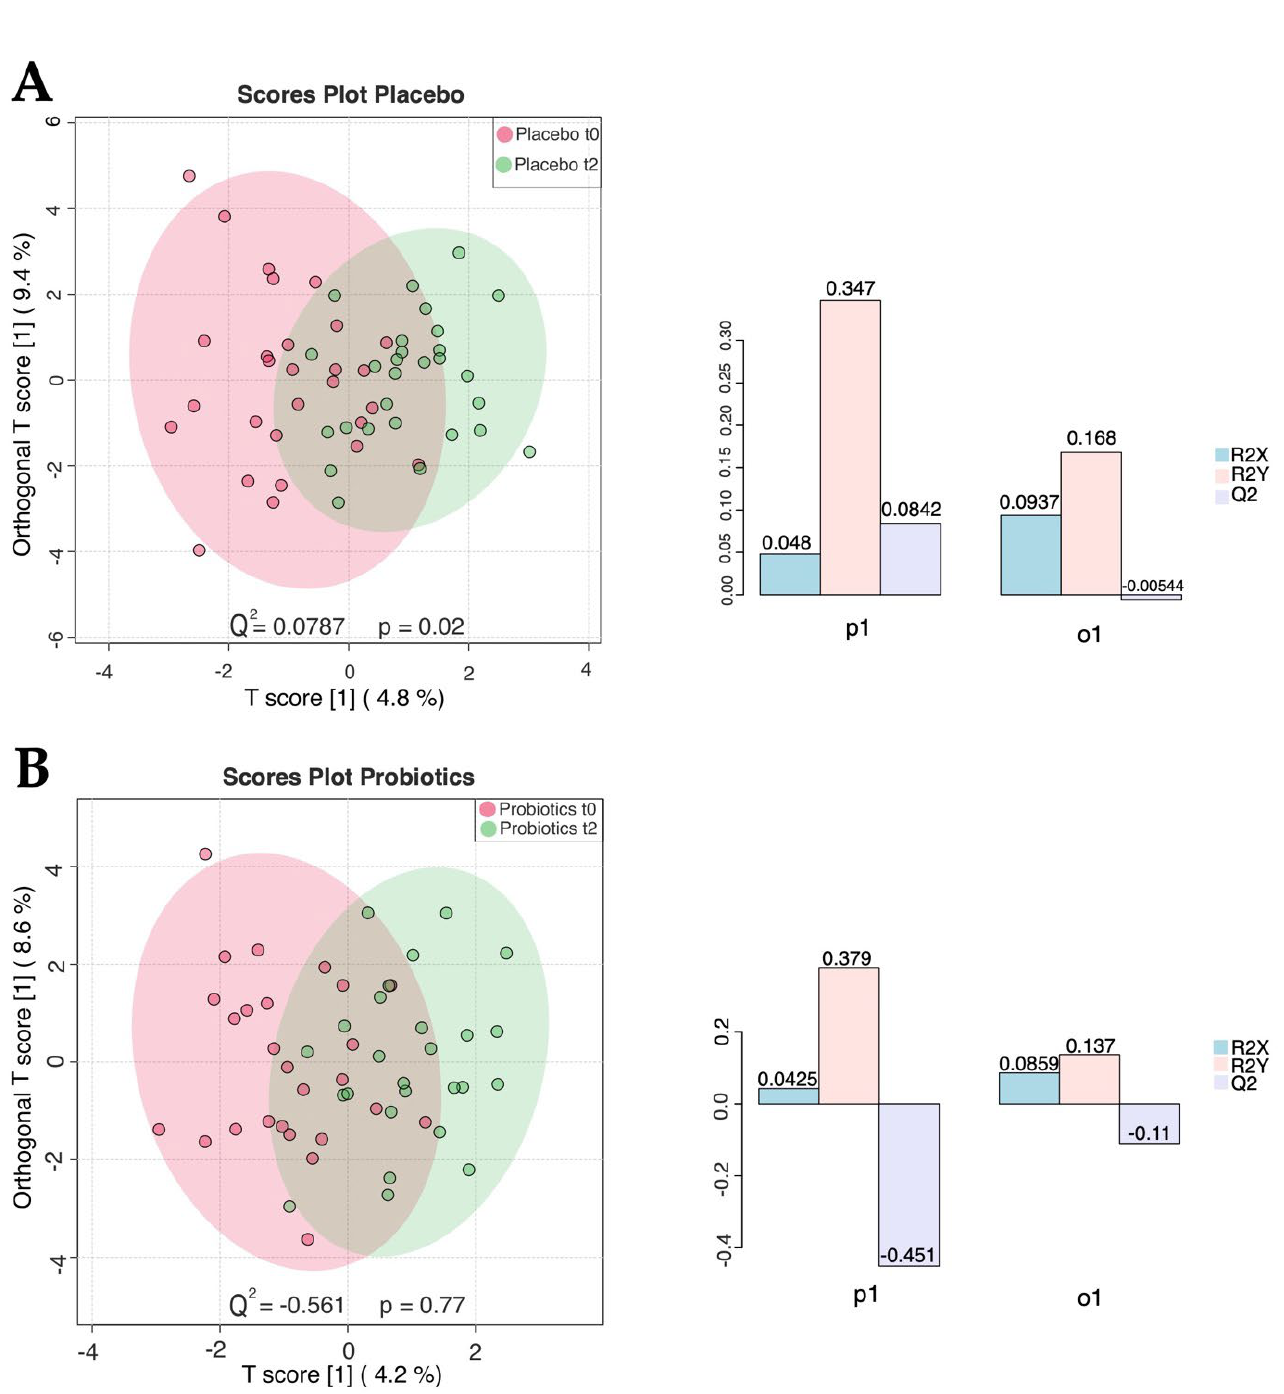
Figure 2. Untargeted metabolomics of the placebo ( n = 29) and intervention group ( n = 28) in serum. ( A ) OPLS-DA: T score of 4.8% and Orthogonal T score 2 of 9.4%. Showing minimal clustering Q 2 of 0.0787 and p -value of 0.02. Time points: (1) Admission t 0 , (2) end of the trial t 2 in the placebo group. ( B ) OPLS-DA: T score of 4.2% and Orthogonal T score 2 of 8.6%, showing no significant clustering Q 2 of 0.0787 and p- value of 0.02. Time points: (1) Admission t 0 , (2) end of the trial t 2 in the placebo group.